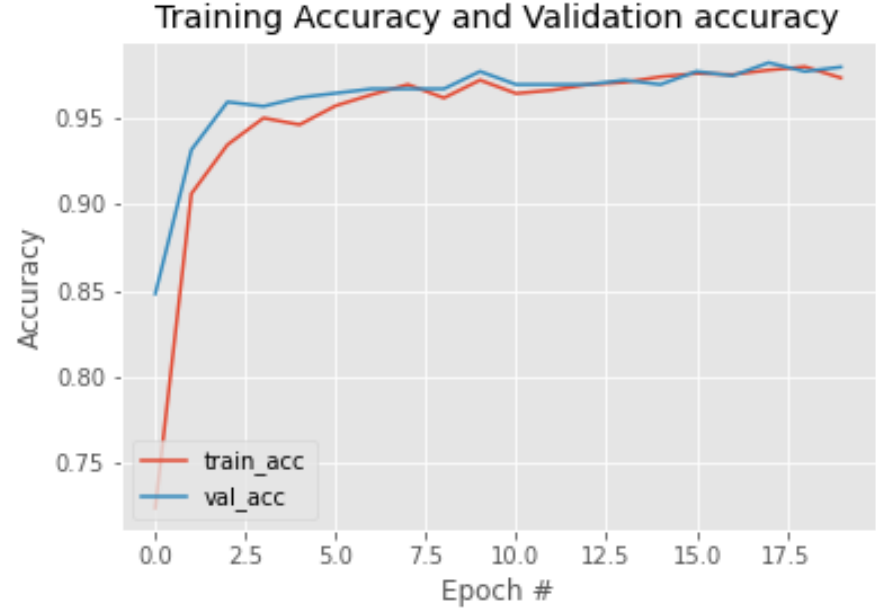
Figure 9. Training and validation